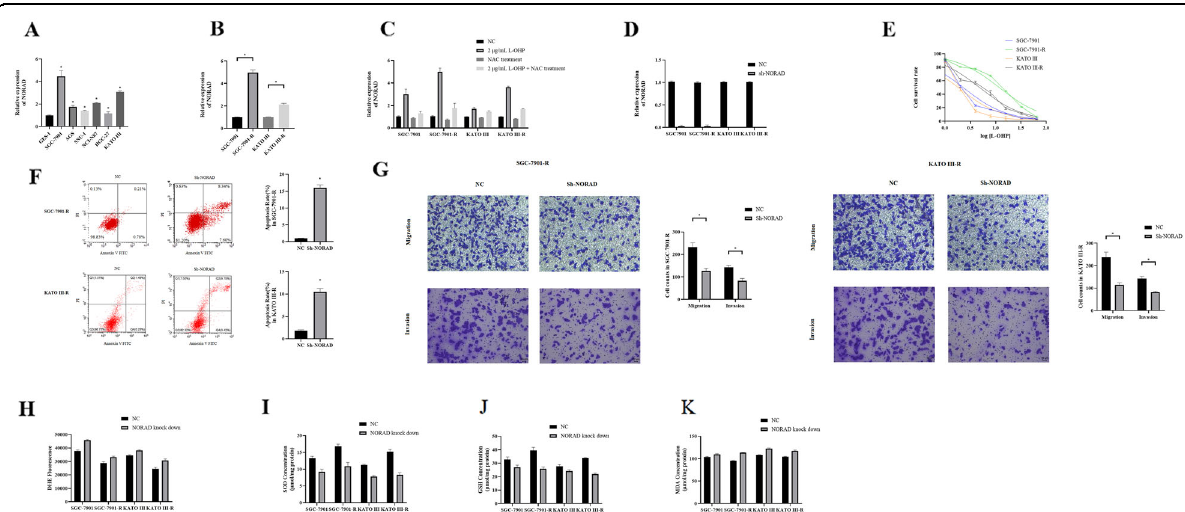
Fig. 3 NORAD induced oxaliplatin resistance of gastric cancer cell. A qRT-PCR to test the expression of NORAD in gastric cancer cells compared with gastric normal cell, GES-1. One-way ANOVA test was used to test the difference of NORAD expression. GES-1 vs SGC-7901, q = 19.97, P < 0.000; GES-1 vs AGS, q = 4.28, P < 0.004; GES-1 vs SNU-1, q = 2.21, P = 0.174; GES-1 vs HGC-27, q = 6.35, P = 0.864; GES-1 vs KATO III, q = 0.916, P < 0.000.